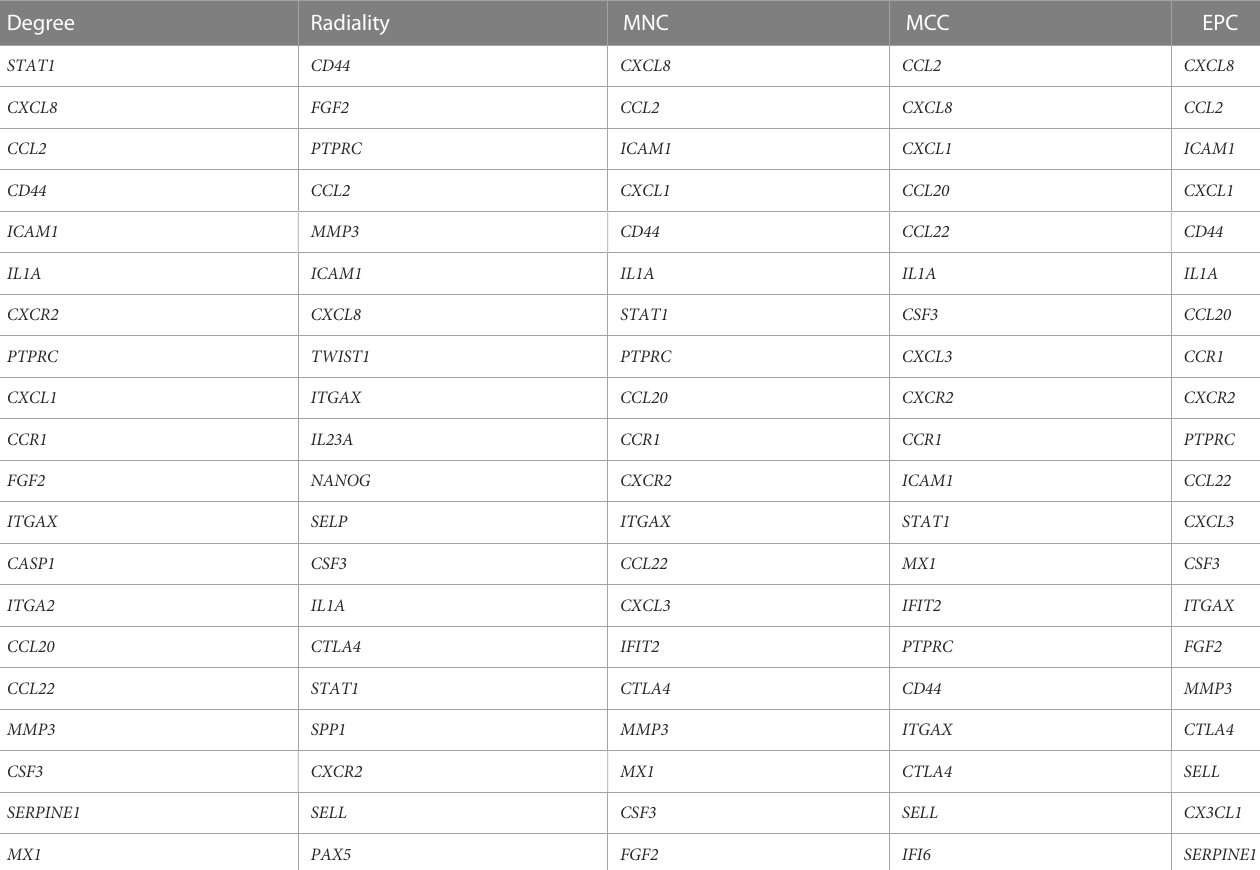
TABLE 2 The top 20 hub genes rank in